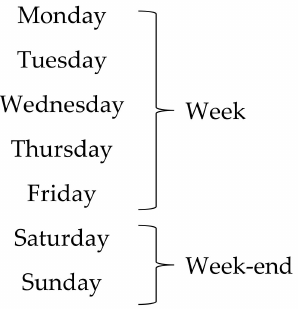
Figure 10. Division of the input 2